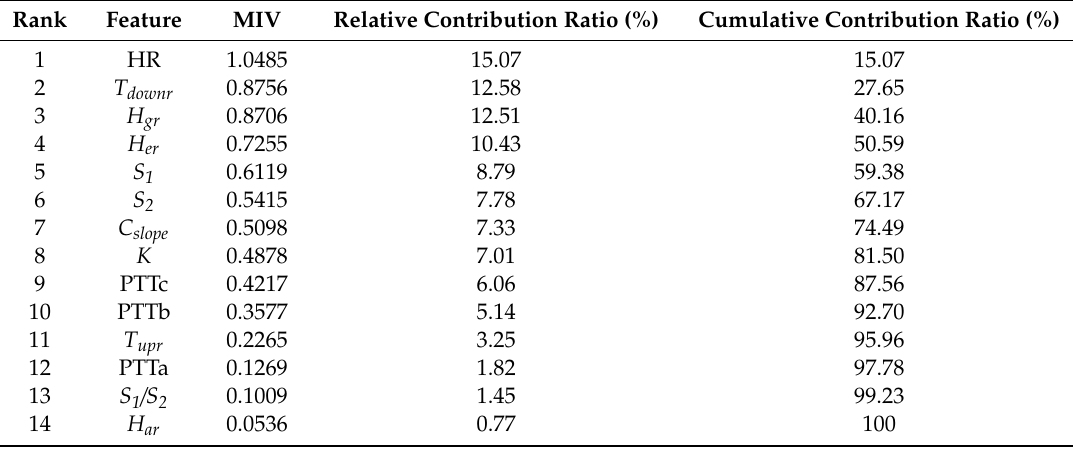
Table 3. MIV ranking of features regarding the DBP estimation model using